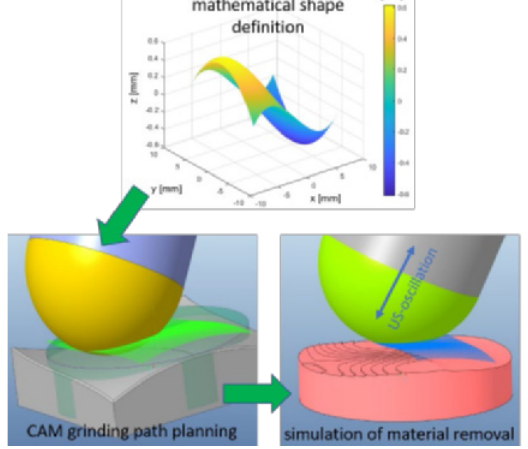
Fig. 2. Digital preparation of freeform grinding process, including geometry definition, optical design and CAD/CAM programming